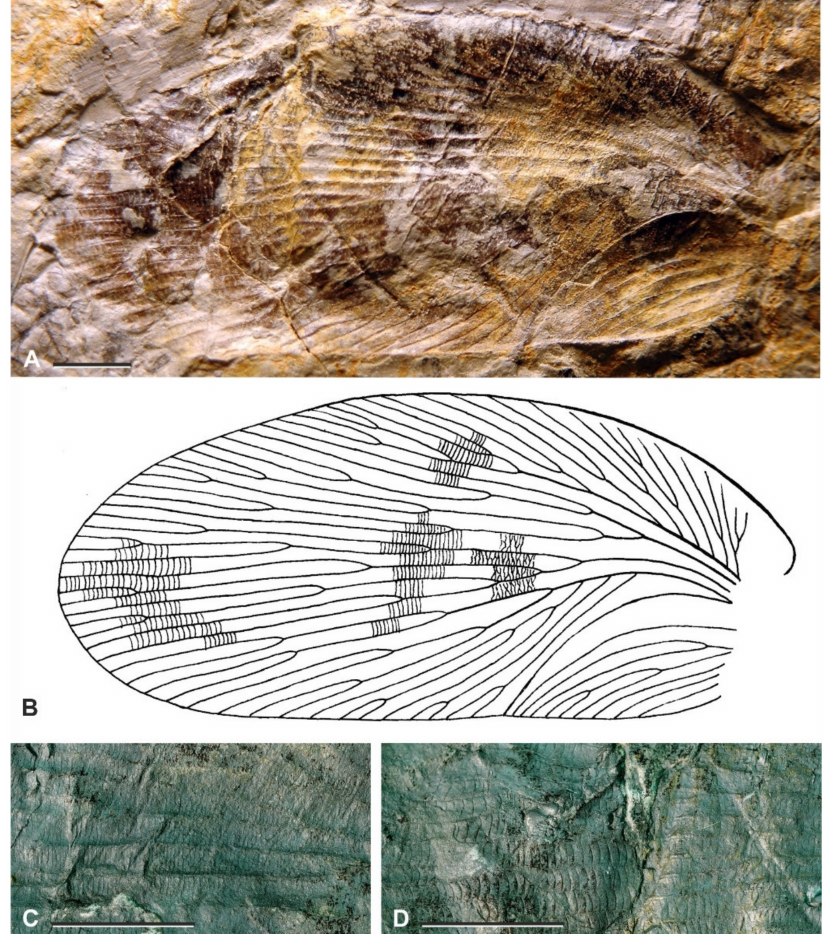
Figure 11. ( A , B )— Progonoblattina helvetica (Heer, 1864): specimen ‘ Necymylacris sp.’, Schneider et al., (2005); Cainsdorf near Zwickau; MfNC F15186; length 51 mm; ( C )—detail of the cross venation at R; ( D )—detail of the cross venation close to the wing tip at M; scale bars 5